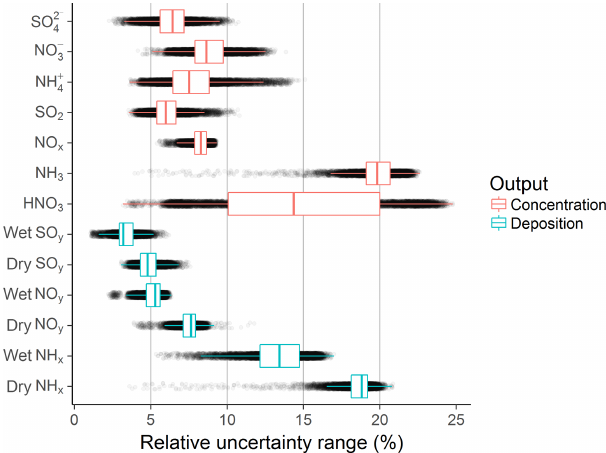
Figure 4. Distributions of relative uncertainty values calculated for all FRAME model outputs across all model grid squares given the following input uncertainty ranges: ± 4, ± 10, and ± 20% in emis- sions of SO 2 , NO x , and NH 3 respectively. Boxes demarcate the median and lower and upper quartiles of the distributions; whiskers extend to 1.5 times the interquartile